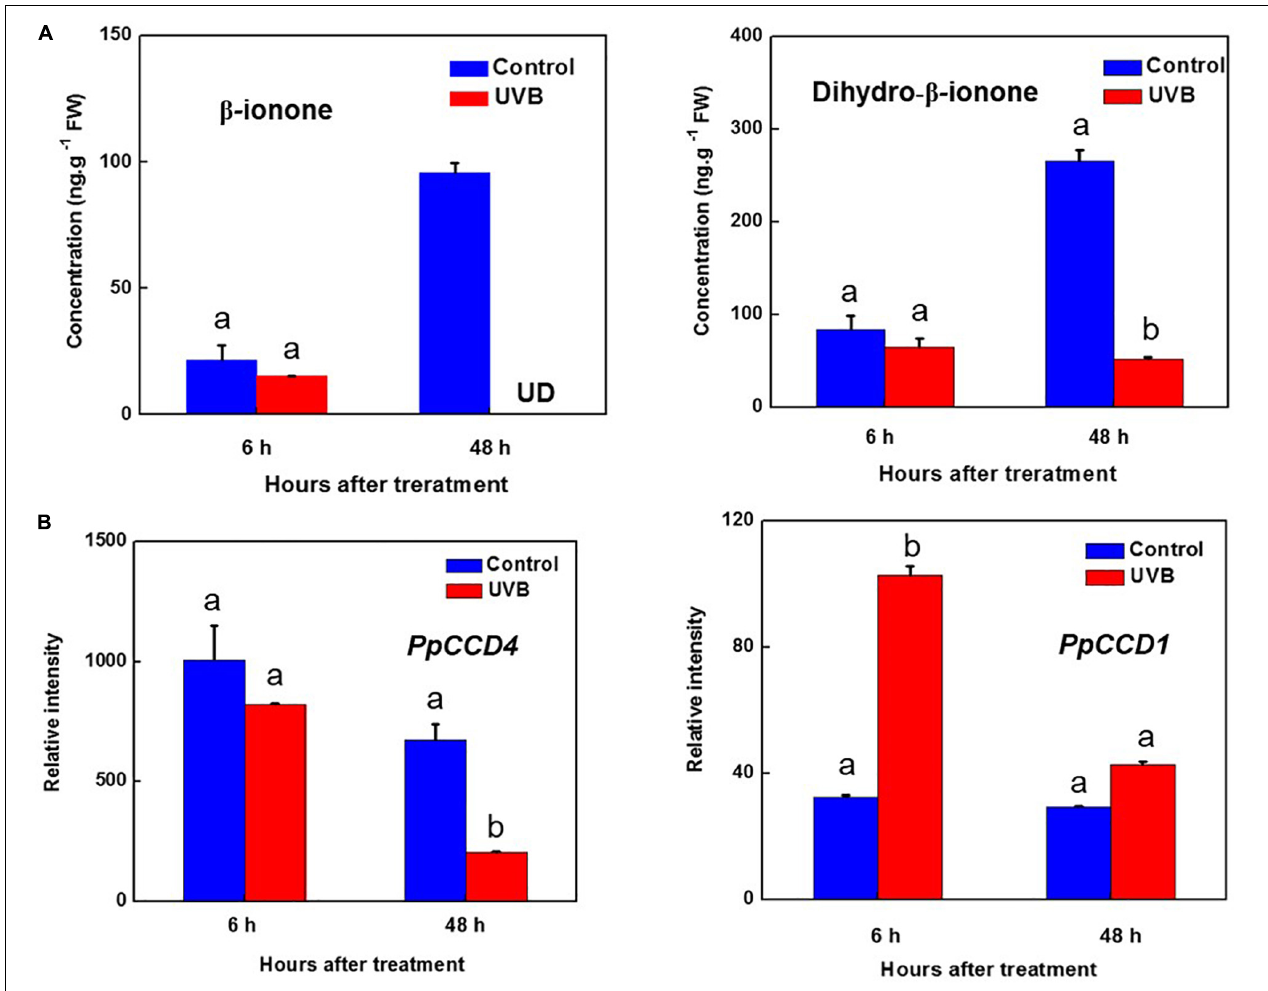
FIGURE 4 | Transcript levels of PpCCDs and content of norisoprenoids changed by UV-B irradiation. (A) Content of the β -ionone and Dihydro- β -ionone. (B) Transcript levels of PpCCD4 and PpCCD1. Different letters indicate significant differences between UV-B treatment and control ( p < 0.05).